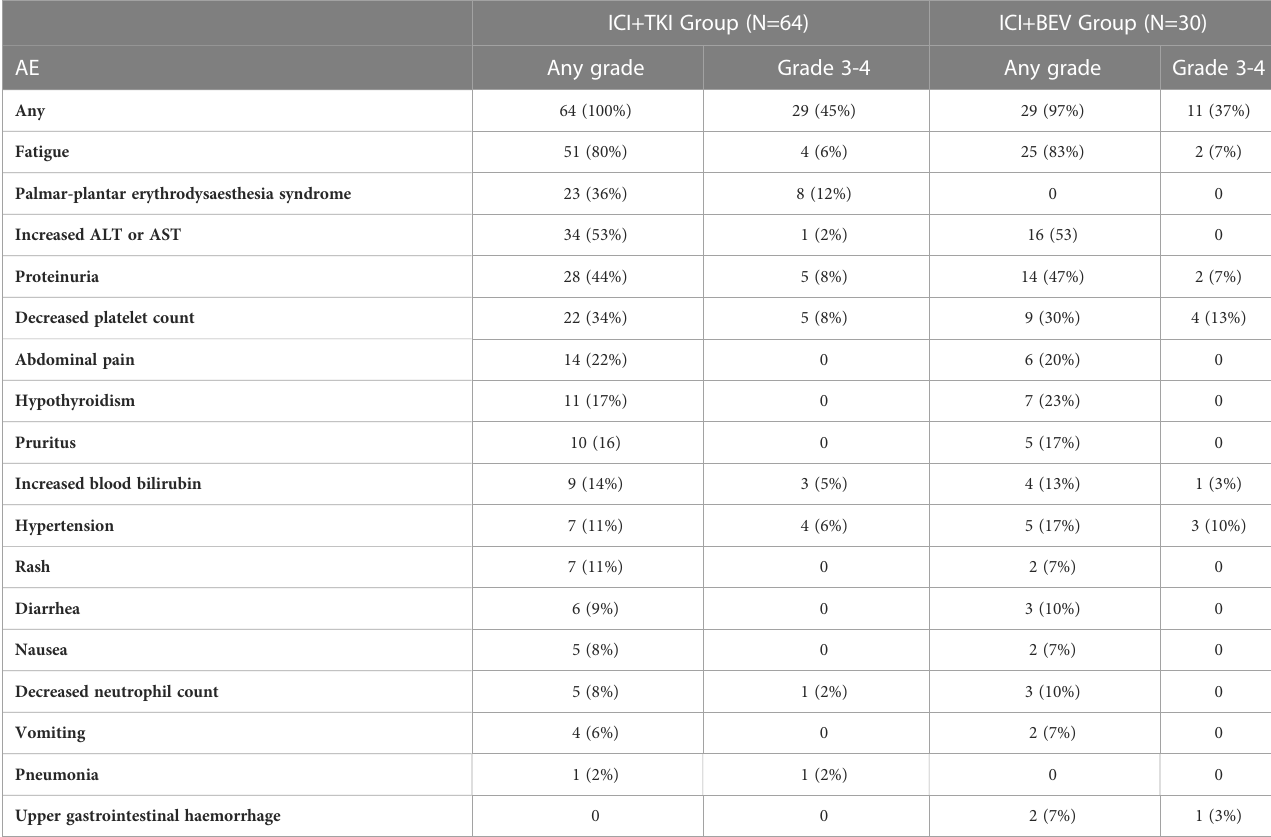
TABLE 3 Common treatment-related adverse